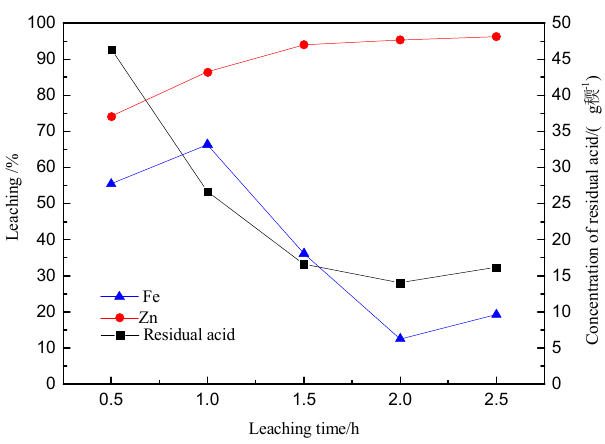
Figure 11. Effect of leaching time on extractions of Zn and Fe. Figure 11. E ff ect of leaching time on extractions of Zn and Fe.